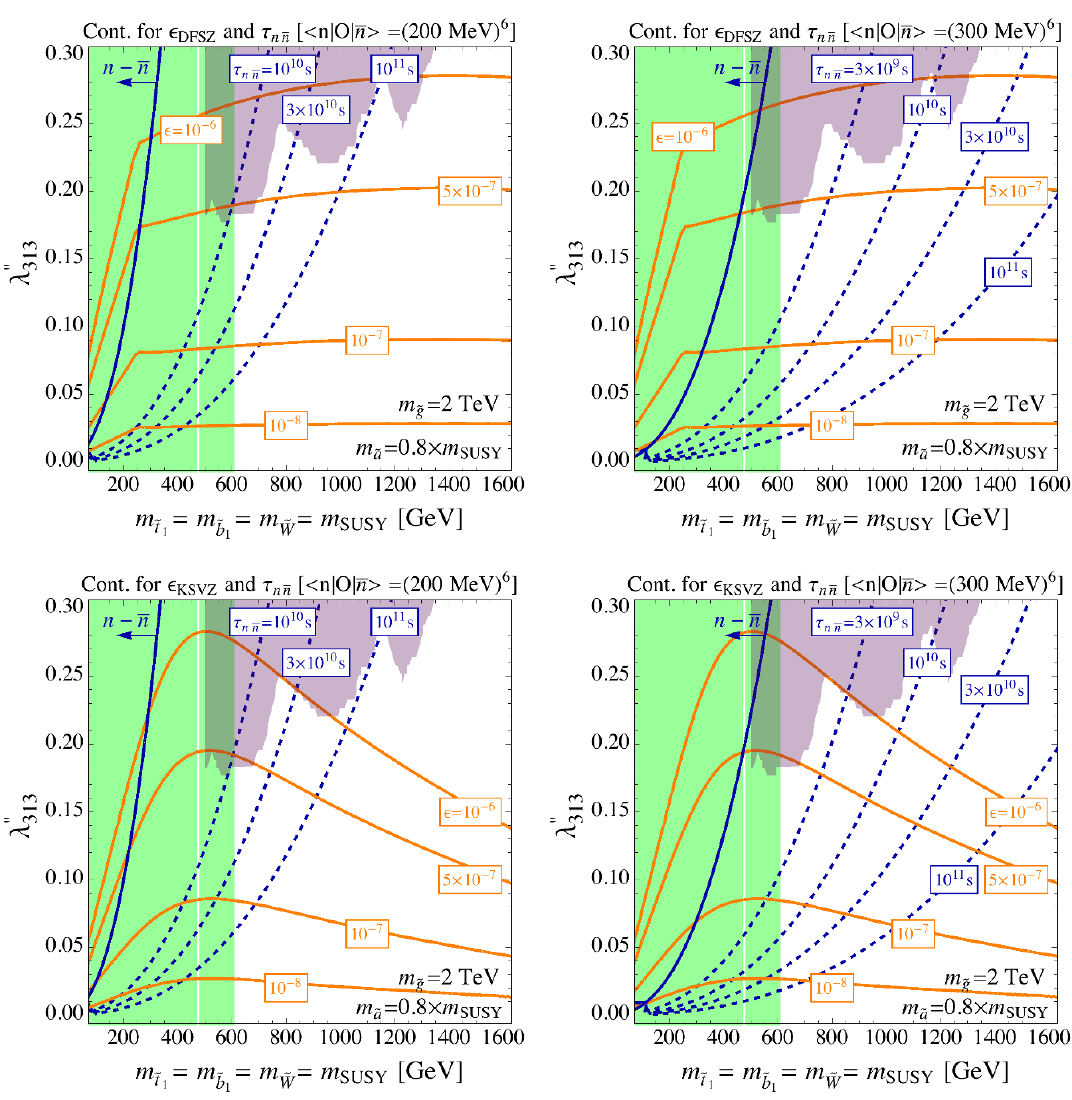
Figure 5 . Exclusion on the n (cid:0) n oscillation time (cid:28) nn from [2] (solid blue line) and contours for several values of (cid:28) nn (dashed blue line) and the CP asymmetry (cid:15) (orange lines) induced by the axino in the DFSZ ((cid:12)rst row) and KSVZ case (second row), displayed in the plane of a common mass m SUSY and (cid:21) 00 . Stop and sbottom mixing are taken as (cid:18) 313 is the only non-vanishing phase. The other relevant parameters are as indicated in the plots. The light-green area is excluded by the ATLAS four-jets search [35]. The purple area is excluded by resonant stop production [38].